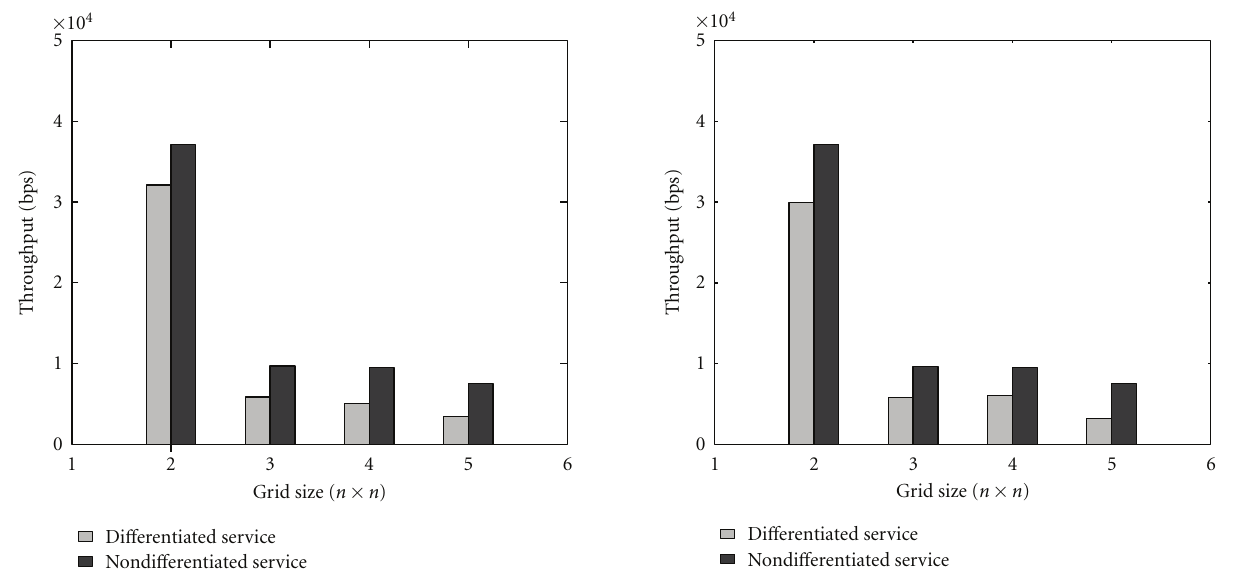
Figure 15: Throughput comparison: di ff erentiated and non- di ff erentiated service for best e ff ort